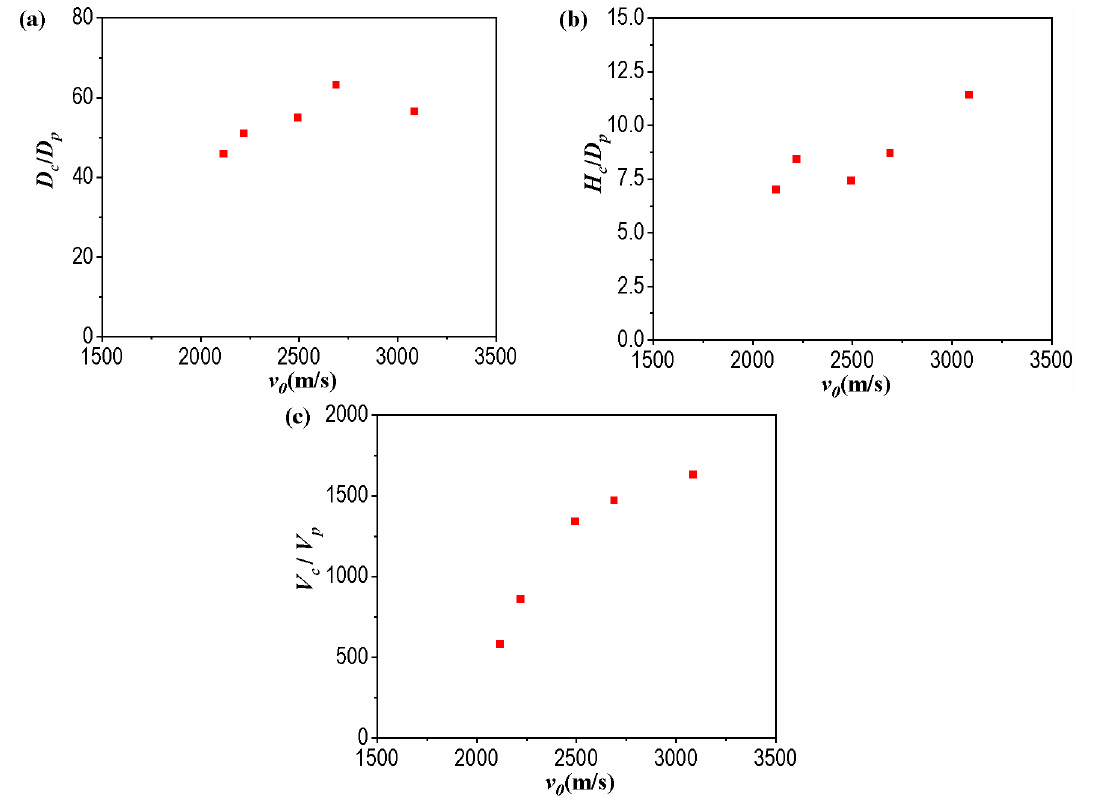
Figure 7. Influence of the impact velocity on ( a ) the non-dimensional equivalent crater diameter, ( b ) the non-dimensional crater depth, ( c ) the non-dimensional crater volume.